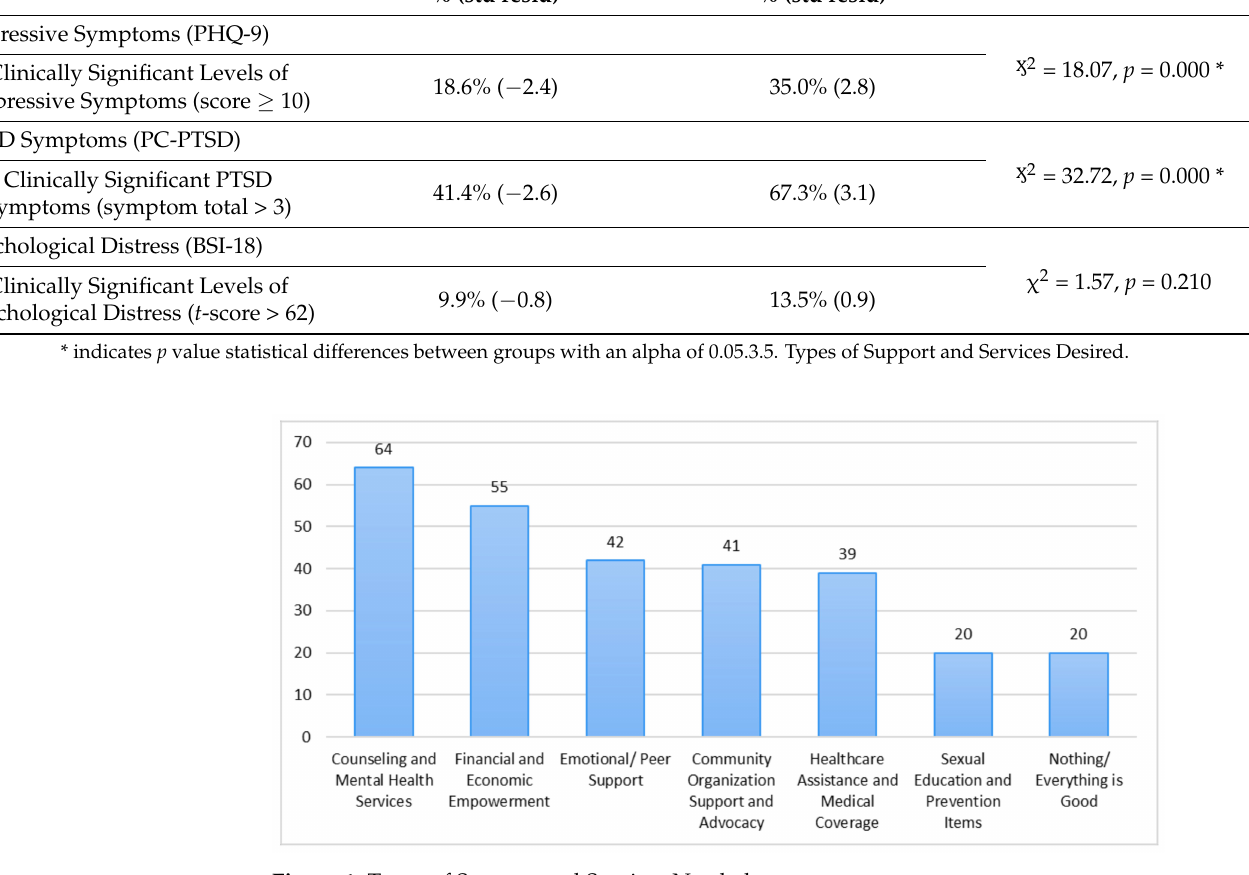
Figure 1. Types of Support and Services